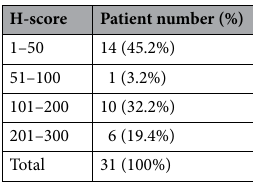
Table 2. Distribution of PR-H-score.